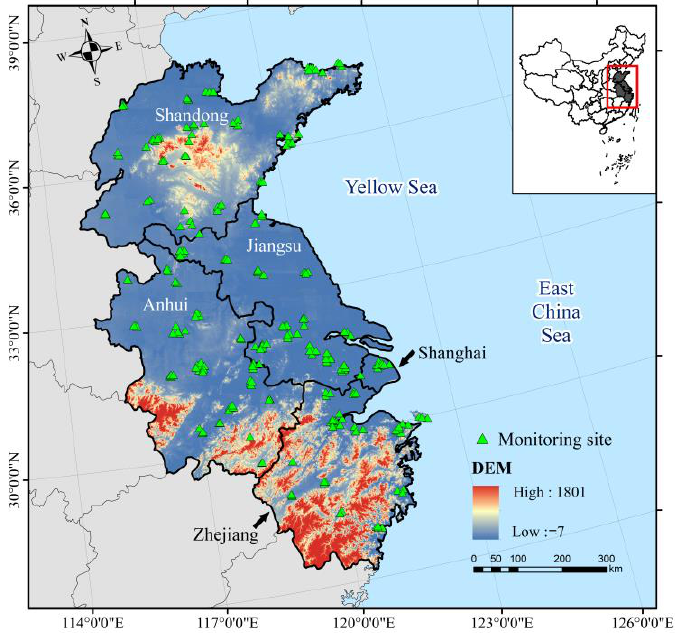
Figure 1. Study area and the distribution of ground O 3 monitoring sites.